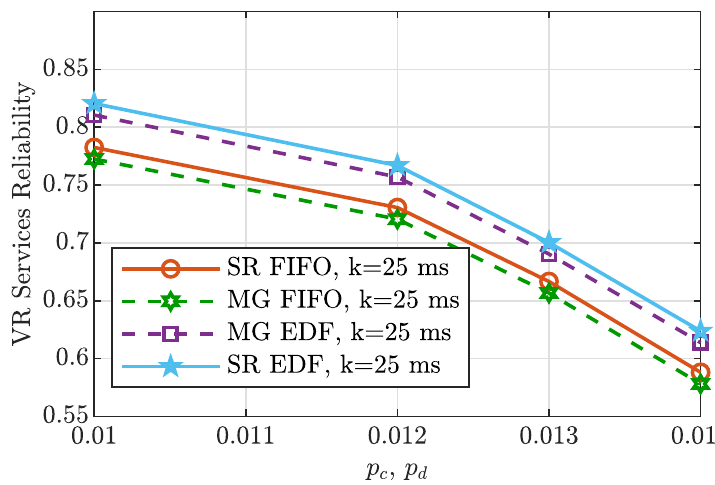
Figure 7. Reliability as a function of p c , p d , considering p H = 0.014, and p G = 0.01.